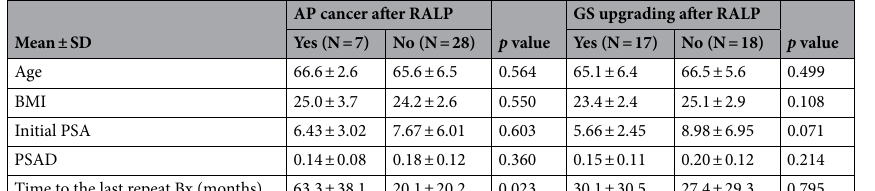
AP cancer after